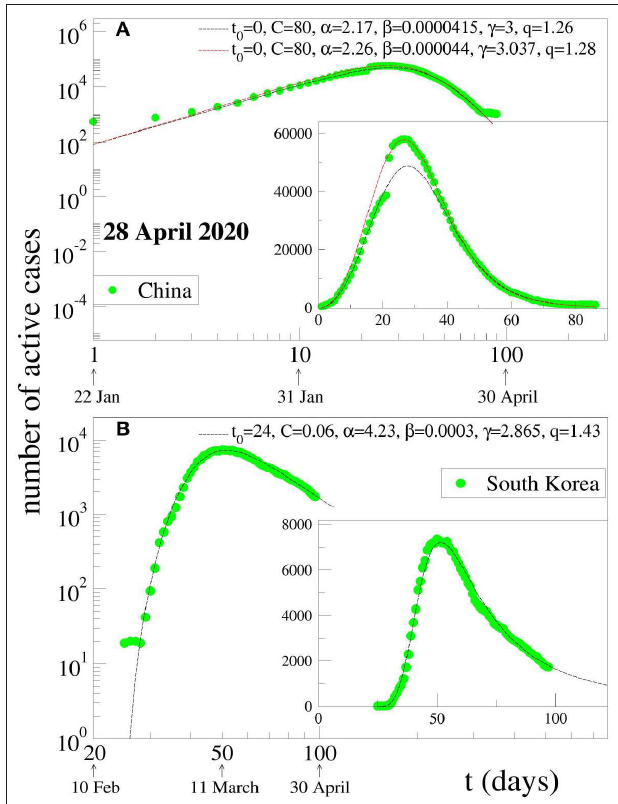
FIGURE 1 | Two possible fits for the evolution of active COVID-19 cases in (A) China and (B) South Korea: the dots are the data available at 28 April 2020, and the lines are fits using Equation (1). For China, a strange kink is present in the ascending part of the data curves, which means that it is not possible to make a single fit that would satisfactorily account for both the increasing and decreasing parts. We here present two log-log representations of different curves that describe either the increasing part or the decreasing part but not both. Inset: linear-linear representation of the same data.